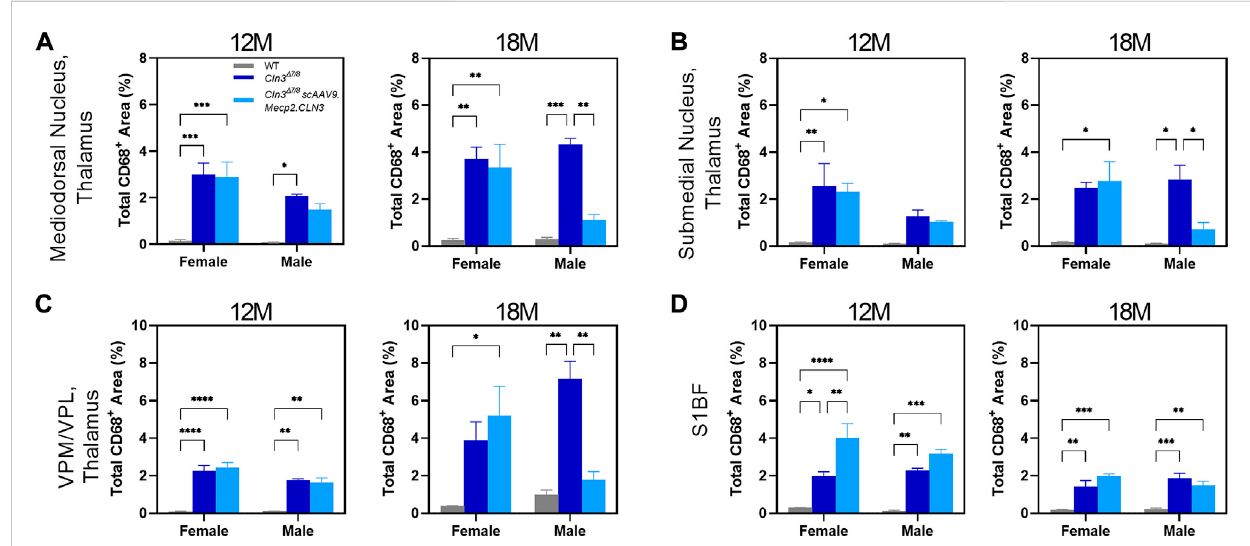
FIGURE 6 Transient, male-speci fi c responses in AAV9 mediated microglial suppression. Previously undescribed microglial activation was found in the mediodorsalnucleus ofthethalamus (A) and submedial nucleusof thethalamus (B) at12 months ofage. Additionally, therewas amale speci fi cresponse in AAV9-mediated reduction of microglial activation at 18 months of age in these two regions, as well as in the previously described VPM/VPL (C) . There were no sex differences detected in the S1BF (D) . Two-way ANOVA, Tukey correction at each time point. Mean ± SEM. * p < 0.05, ** p < 0.01, *** p < 0.001, **** p < 0.0001. 12 images/region/animal were